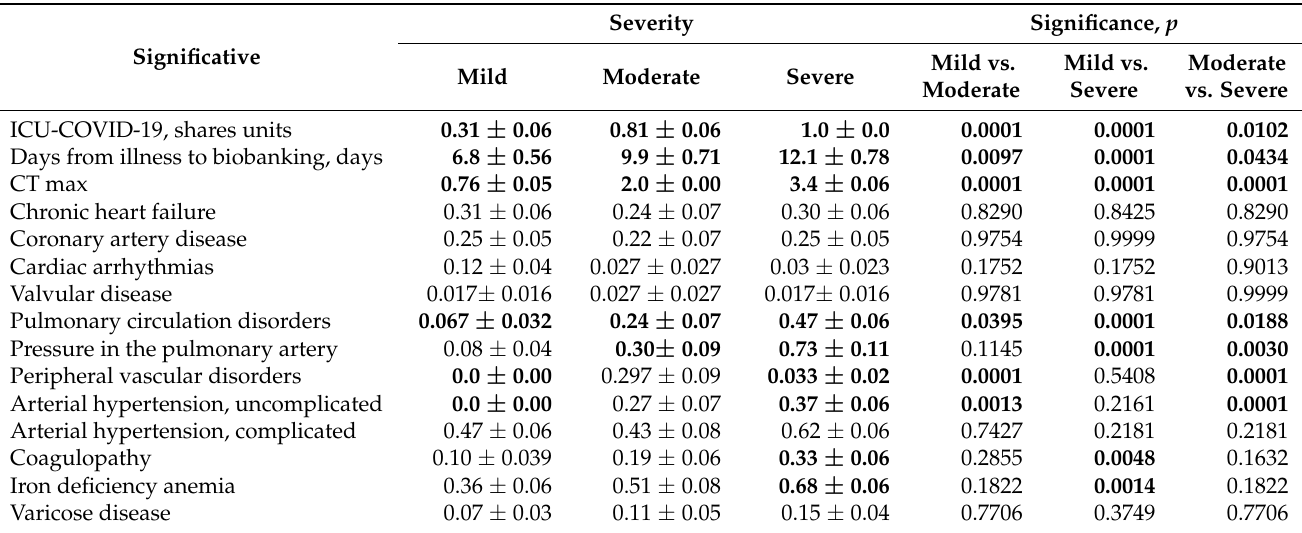
Table 2. Changes in clinical parameters depending on the severity of COVID-19